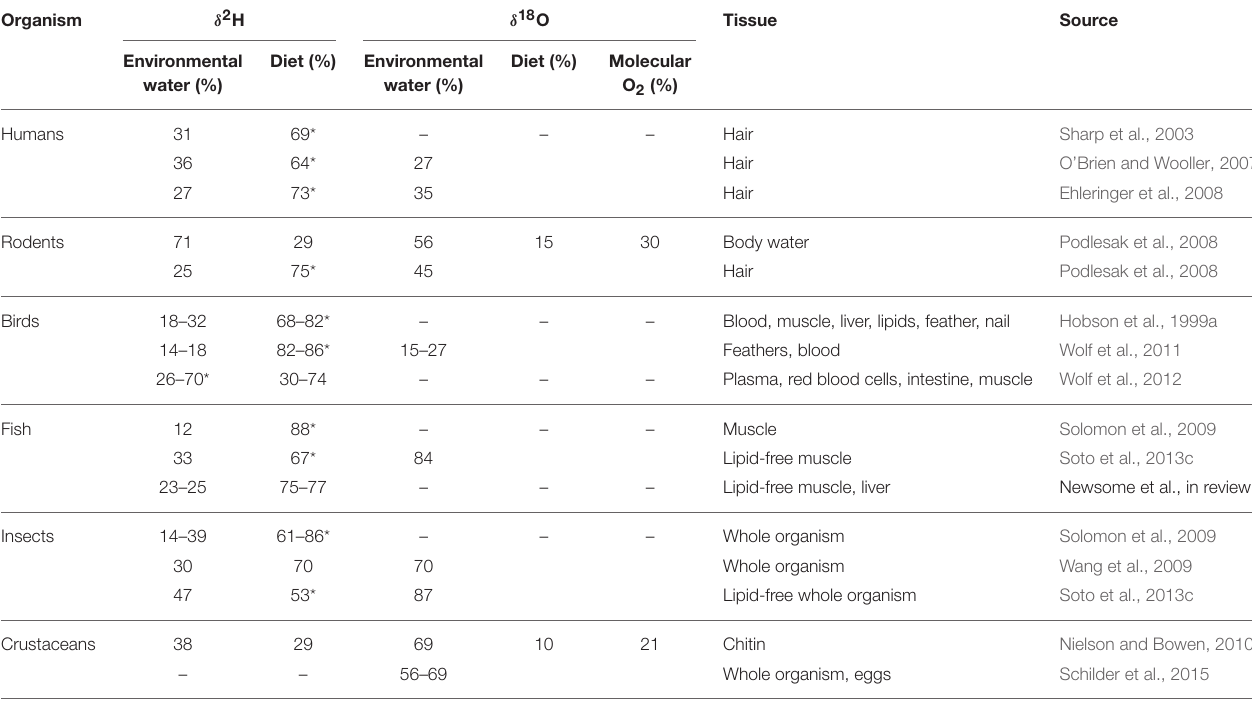
TABLE 1 | Measured source contributions to organismal tissue δ 2 H and δ 18 O values.